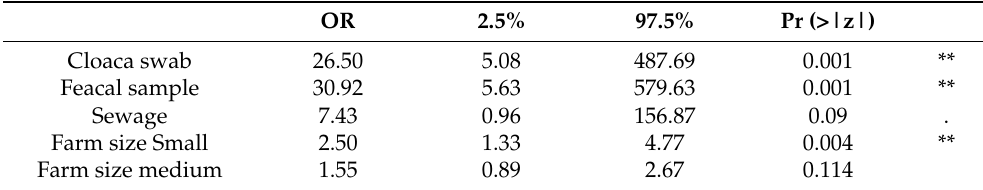
Table 5. Multivariate regression analysis of risk factors for antimicrobial-resistant E. coli from poultry farms in east coast of Malaysia.